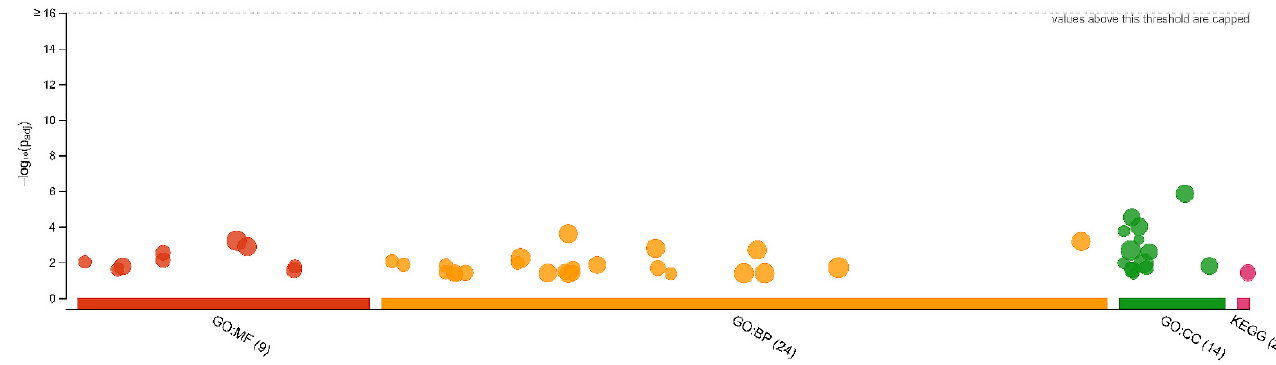
Figure 1. Volcano plot of the proteins identified by LC–MS/MS in CHEM vs. CTR comparison. The volcano plot shows the fold-change ( x -axis) versus the significance ( y -axis) of the identified differentially regulated proteins (DRPs) under the influence of CHEM. The significance (non-adjusted p -value) and the fold-change are converted to − Log10( p -value) and Log2(fold-change), respectively. The vertical and horizontal dotted lines show the cut-off of fold-change = ±1.2, and of p -value = 0.05, respectively. The chosen DRPs are labeled by the gene symbols.